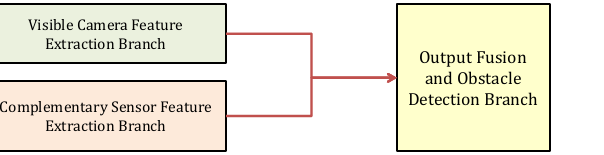
Figure 3. An overview of the skip connection-based fusion and obstacle detection architecture.